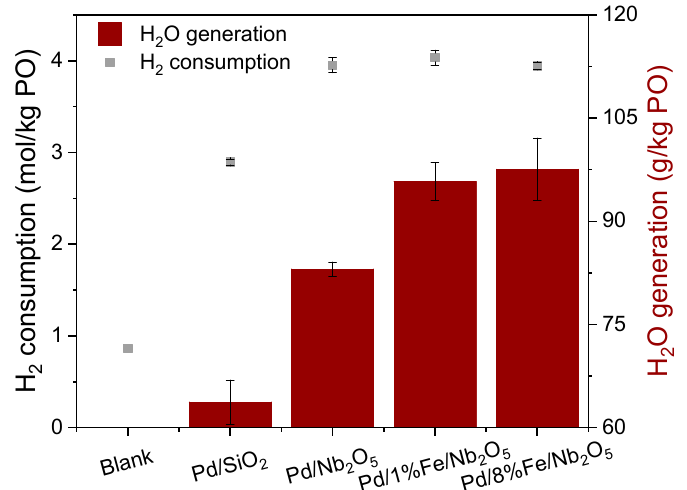
Figure 2. Hydrogen consumption and water increase during the bio-crude hydrotreatment on different catalysts.